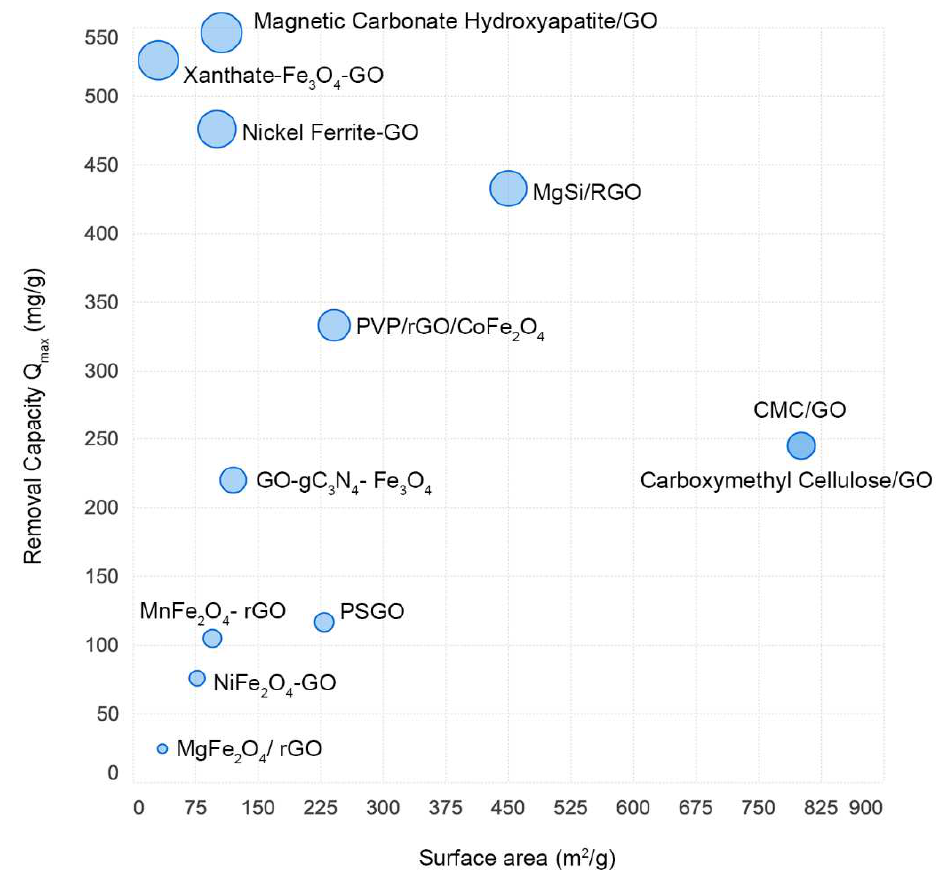
Figure 2. Removal efficiency of heavy metals by various graphene oxide–metal hybrids.